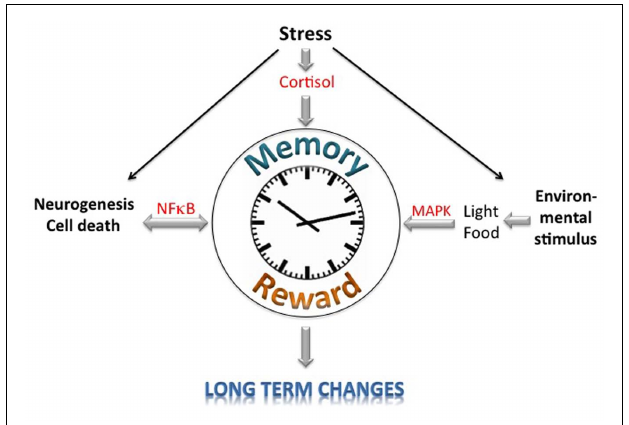
FIGURE 1 | Schematic diagramm of the potential integration of memory, reward, and circadian clock information. Signaling pathways affecting the learning/memory, reward, and circadian clock systems are